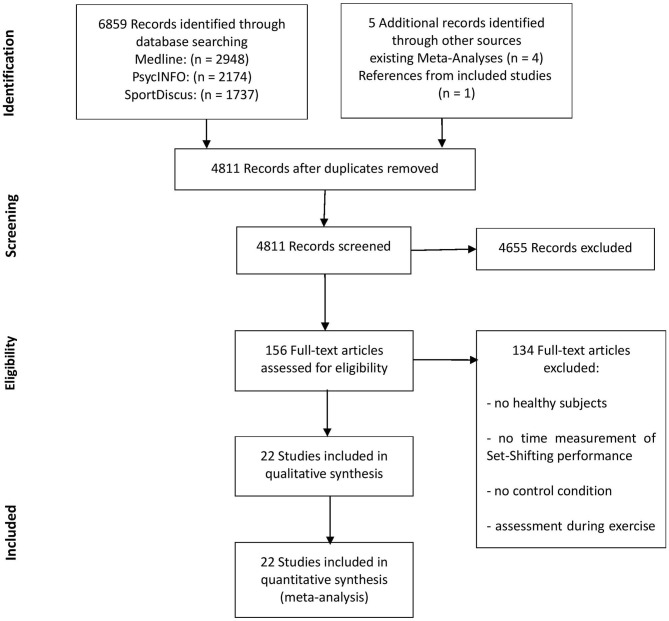
Study selection flow chart according to the PRISMA guidelines.